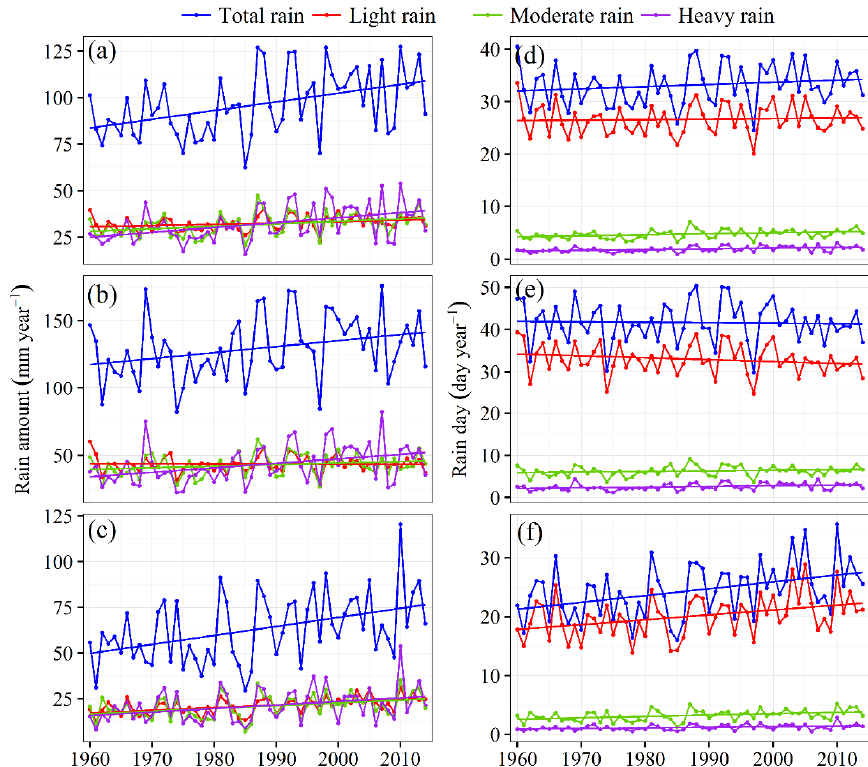
Figure 3. Temporal trends in rain amounts (mm/year) and days (day/year) for total rain and the three classes (light, moderate, and heavy rain) in Xinjiang, northern Xinjiang, and southern Xinjiang during the warm season from 1960–2014. ( a ) Rain amounts in Xinjiang; ( b ) Rain amounts in northern Xinjiang; ( c ) Rain amounts in southern Xinjiang; ( d ) Rain days in Xinjiang; ( e ) Rain days in northern Xinjiang; and ( f ) Rain days in southern Xinjiang.